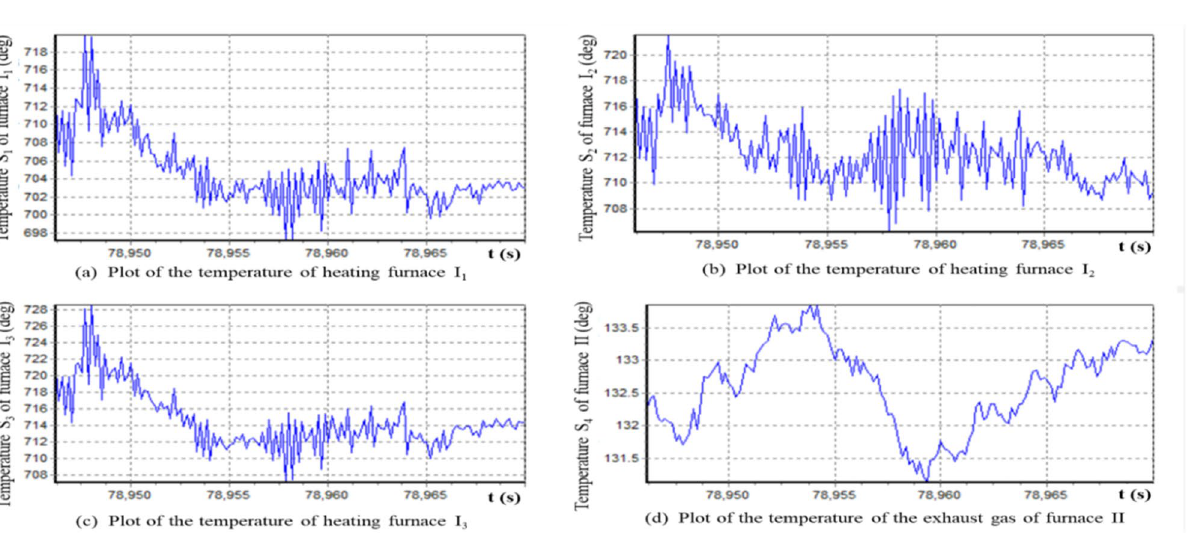
Figure 3. Plots of the temperature of furnace I and the temperature of the exhaust gas from furnace